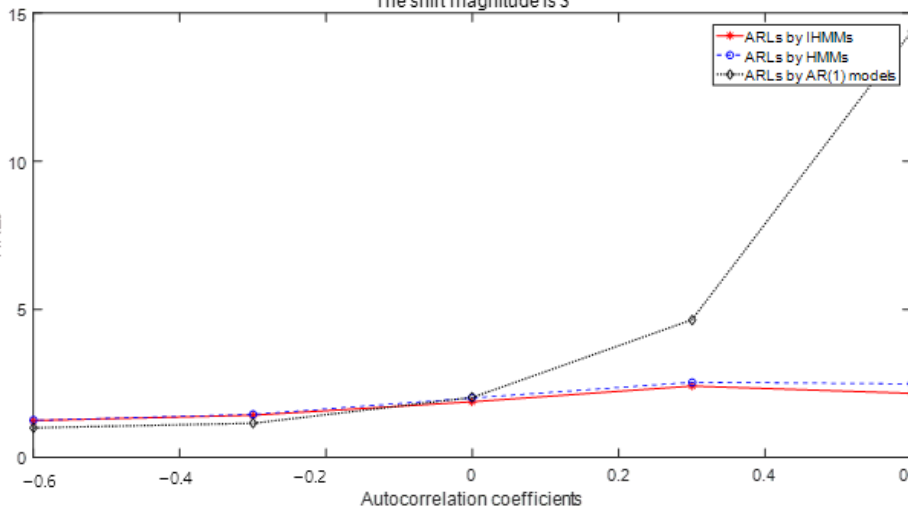
Figure 6. The ARLs of residual charts obtained by different models when the shift magnitude is 1.5.